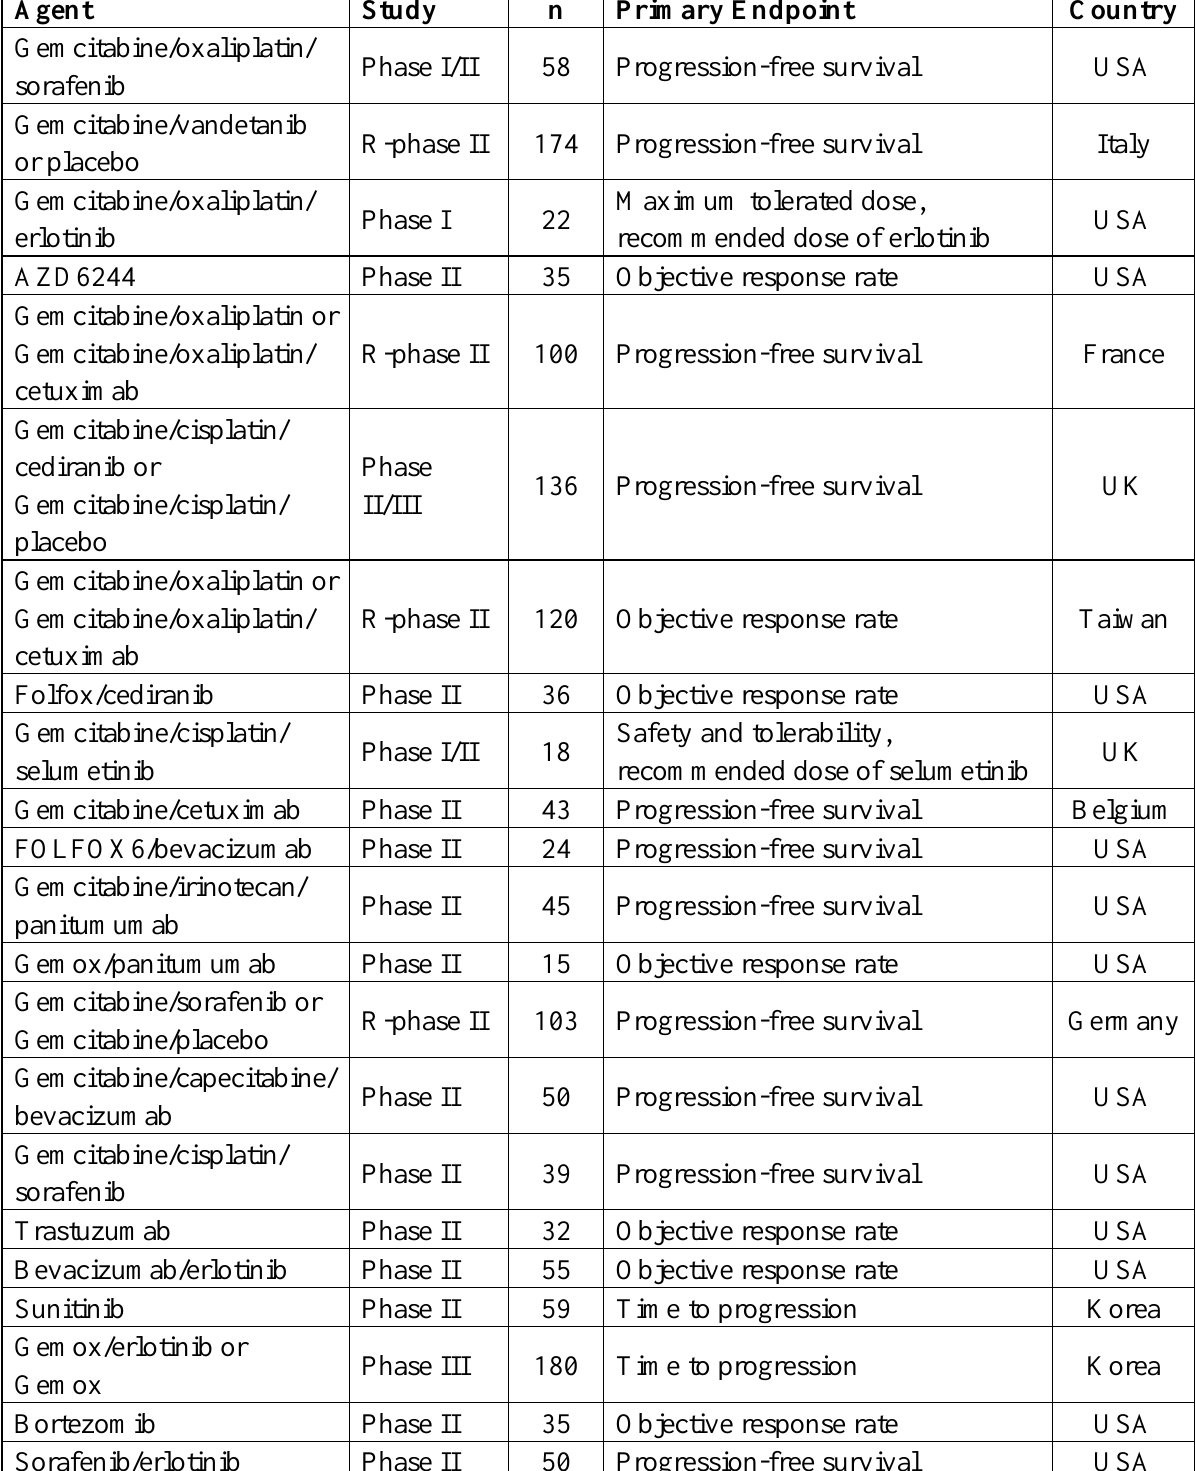
Table 4. Currently ongoing clinical trials of molecular targeted agents for biliary tract